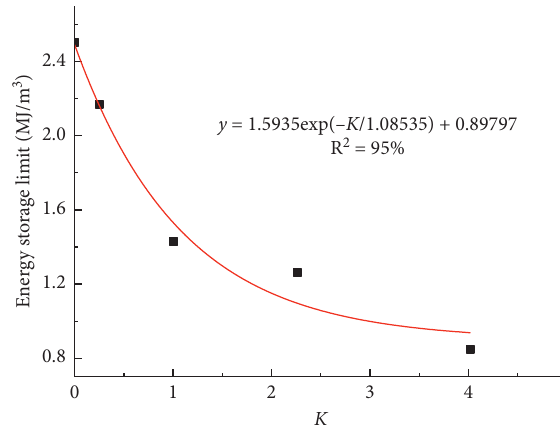
Figure 5: Relationship of the ESL and K